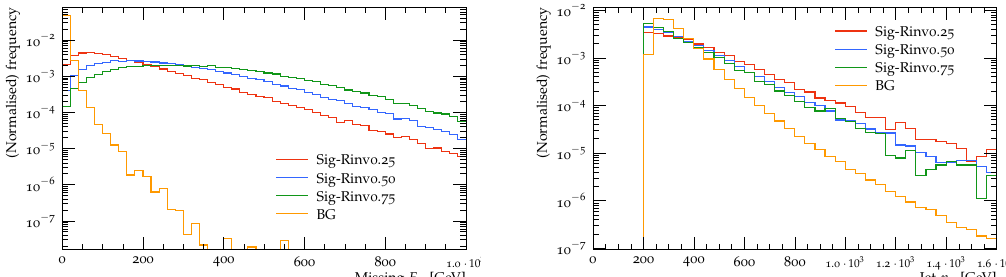
Figure 6: Distributions of MET (right) and leading jet p signals corresponding to R values of 0.25, 0.50 and 0.75, and the background. inv